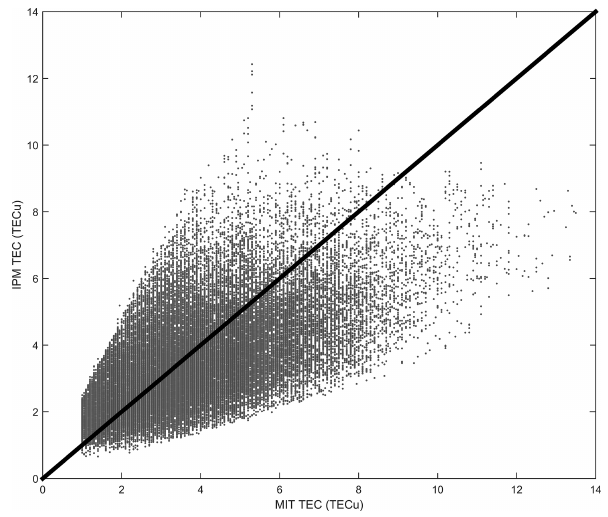
Figure 10. IPM TEC and MIT TEC (TECu) from 25 November 2017 to 8 April